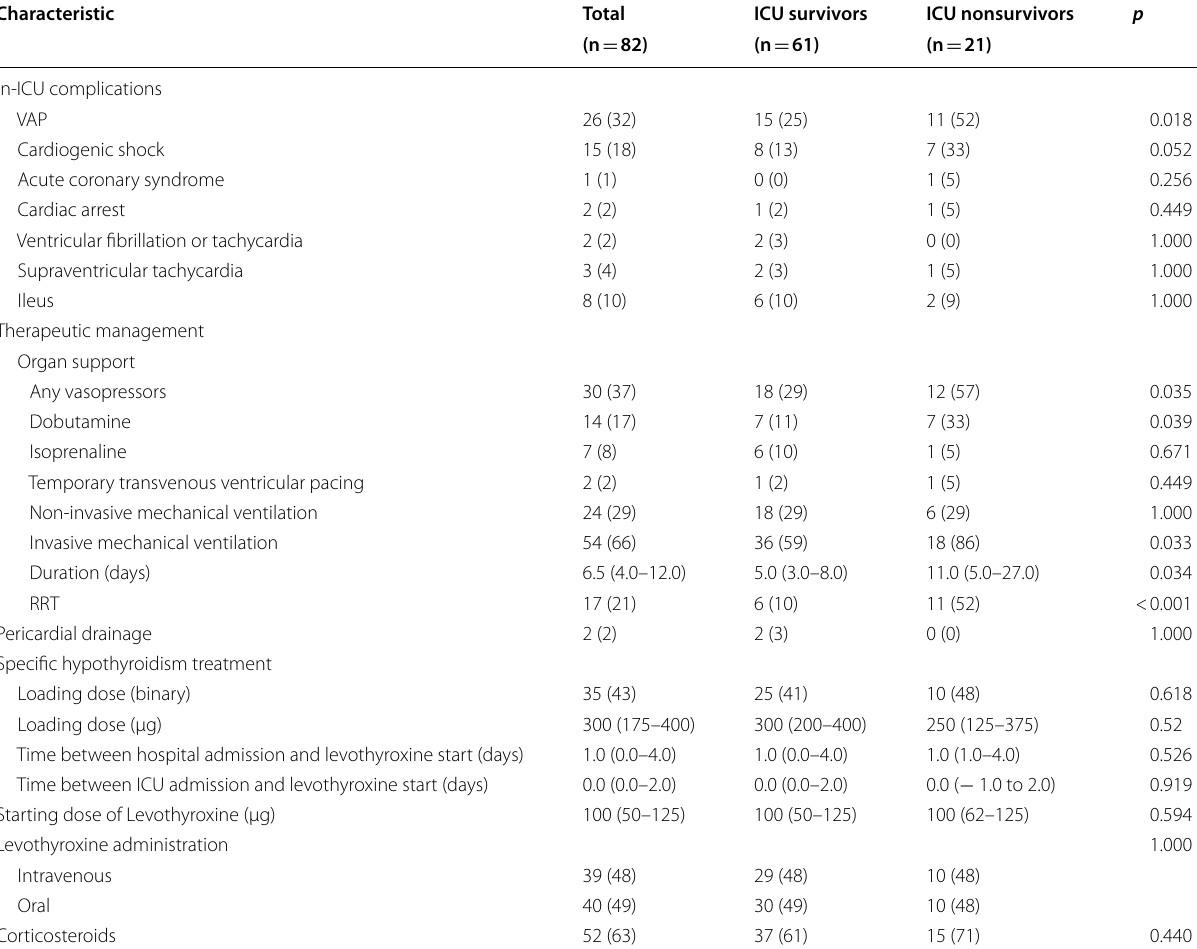
ICU intensive care unit, VAP ventilator-associated pneumonia, RRT renal replacement therapy